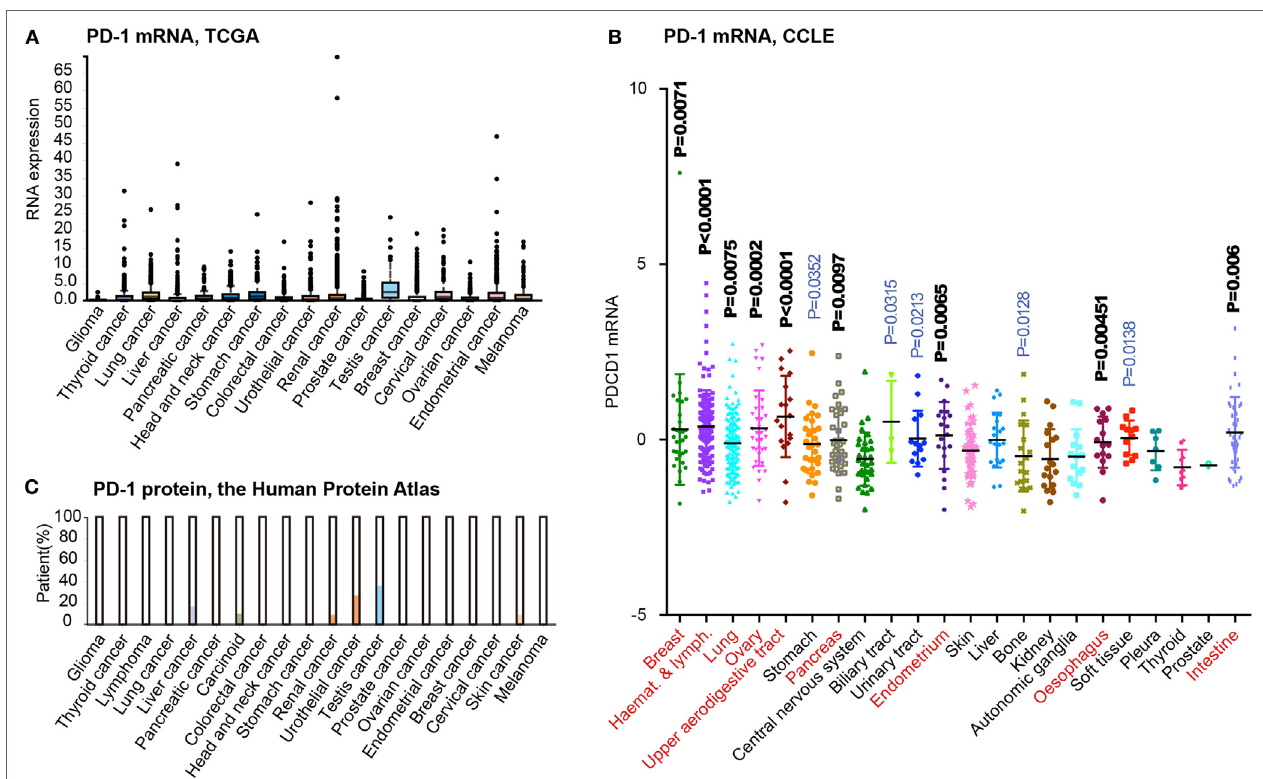
FiGURe 4 | Tumor-intrinsic programmed death 1 (PD-1) expression is widespread in many tumor types. (A) PD-1 mRNA expression level analysis in different cancer tissues from the human protein atlas. (B) PD-1 mRNA expression level analysis in various kinds of cancer cells based on related data from Cancer Cell Line Encyclopedia (CCLE). (C) . PD-1 protein expression level analysis in different cancer tissues using immunohistochemical staining from the human protein atlas. All cancer types were compared to “Central nervous system” tumors by t-test (P-values indicated). Tumors displaying highly significant differences ( P <0.01) are marked by red